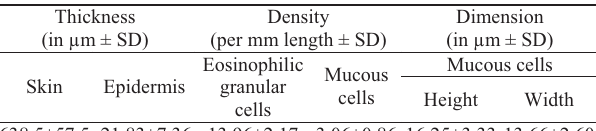
Table 1. Average thickness, density and dimensions of dorsal skin and its cellular components in Ancistrus dolichopterus . Values are given as mean ± SD, n = 3 with 10 replicates per